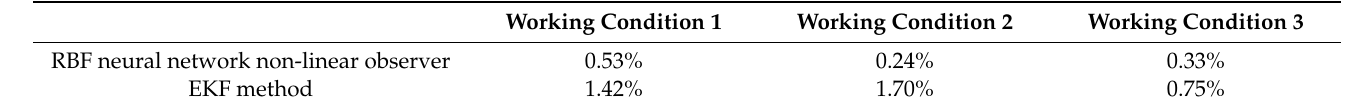
Figure 26. Comparison of SOC estimation error based on non-linear observer and EKF in dynamic condition test 3. Table 2. RMSE of SOC estimation error based on RBF neural network non-linear observer and EKF